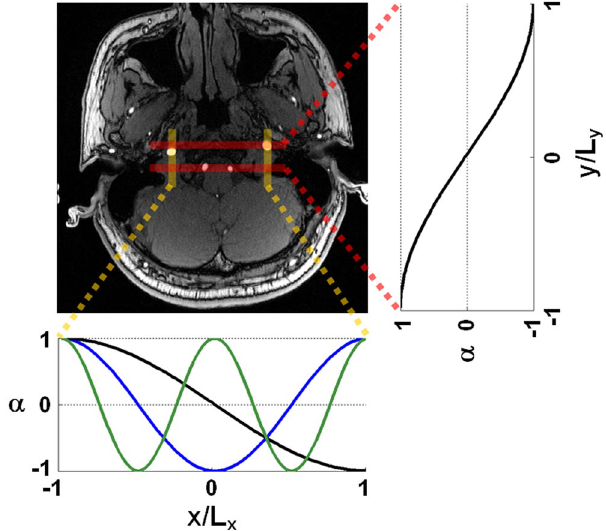
Figure 1. Labeling layout. Labeling was planned by referring to a time-of-flight image where internal carotid arteries and vertebral arteries were most identifiable and most perpendicular to the labeling plane. Labeling efficiency ( α ) was approximately a sinusoidal function of location within a spatial period of encoding (denoted by L x in the left-right direction and L y in the anterior-posterior direction, respectively). In this study, 4 steps were played out as shown by sinusoidal curves (1 step in the anterior-posterior direction and 3 harmonic steps in the left-right